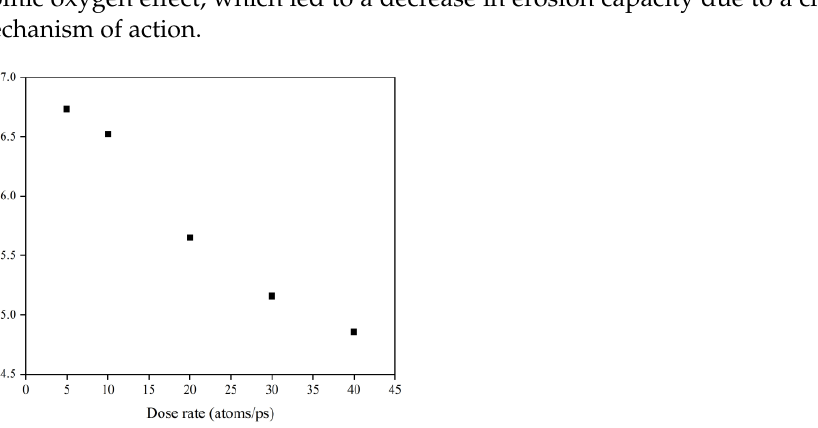
Figure 30. Erosion yield of the Kapton under atomic oxygen impact at different dose rates.